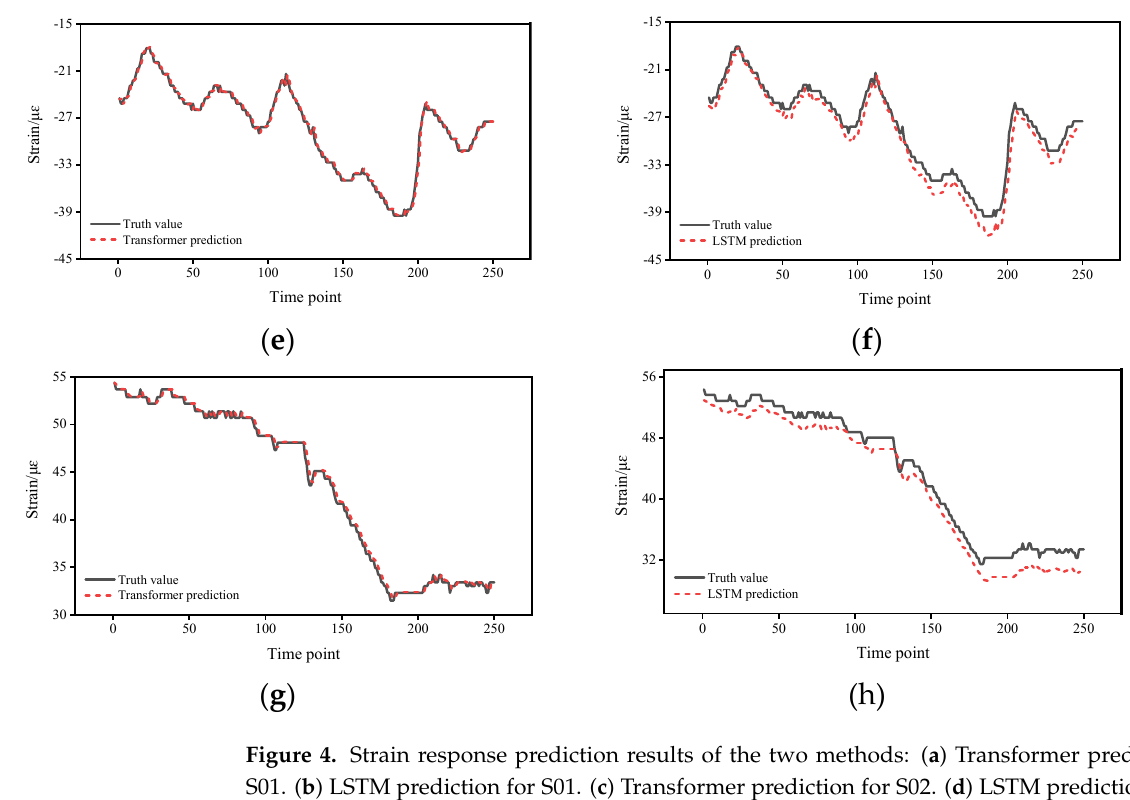
Figure 4. Strain response prediction results of the two methods: ( a ) Transformer prediction for S01. ( b ) LSTM prediction for S01. ( c ) Transformer prediction for S02. ( d ) LSTM prediction for S02. ( e ) Transformer prediction for S03. ( f ) LSTM prediction for S03. ( g ) Transformer prediction for S09. ( h ) LSTM prediction for S09.